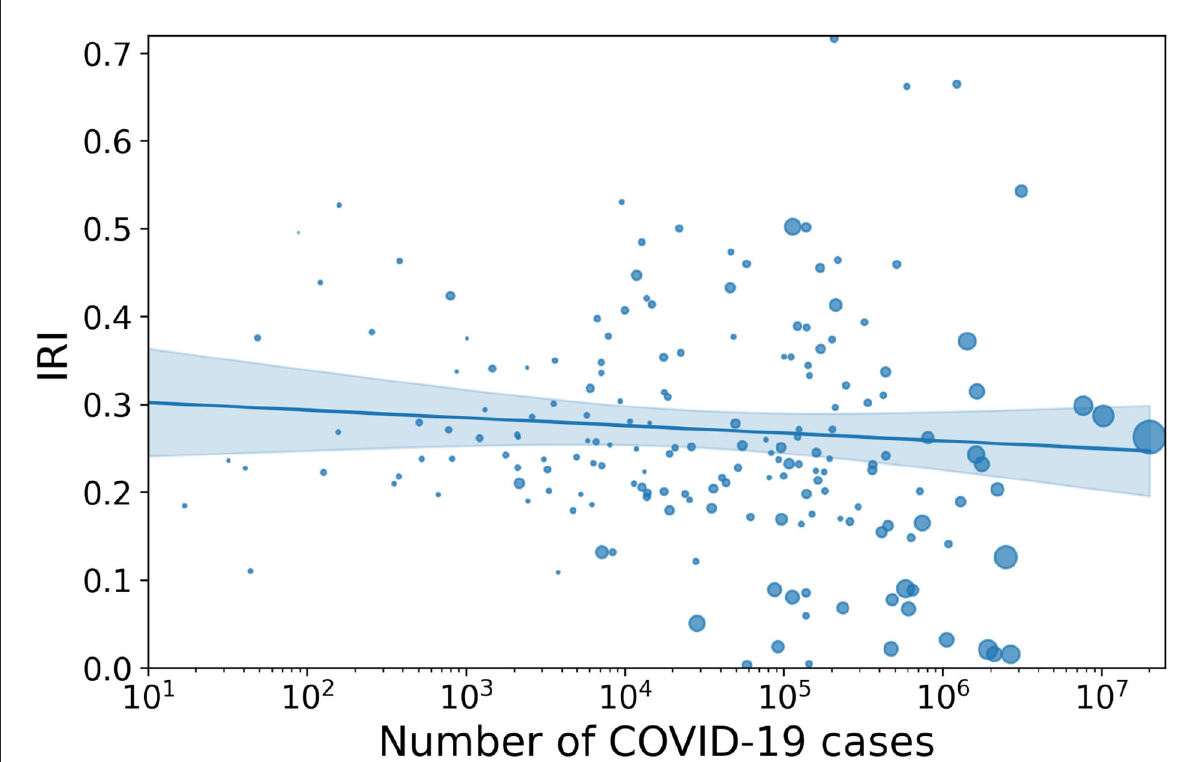
FIGURE1 Correlation between IRI and total number of COVID-19 cases worldwide. Description: scatterplot showing a moderate but significant anti-correlation between COVID-19 cases and IRI across the 177 countries considered (Spearman-r is − 0.16 and the p-value is 0.033). The correlation is strongly reduced as compared to the early days of the pandemic as analyzed in Gallotti et al. (2020), where Spearman-r was − 0.33 and the p -value is 0.0009. The regression curve shown here and in all graphs is a logarithmic regression, which was selected using an Akaike criterion against a linear and a logistic regression. The shaded area represents the 95% confidence interval, and the size of the circle represents the number of Tweets collected. Two countries (Peru and Kosovo) are not visualized in the plot as they have IRI >